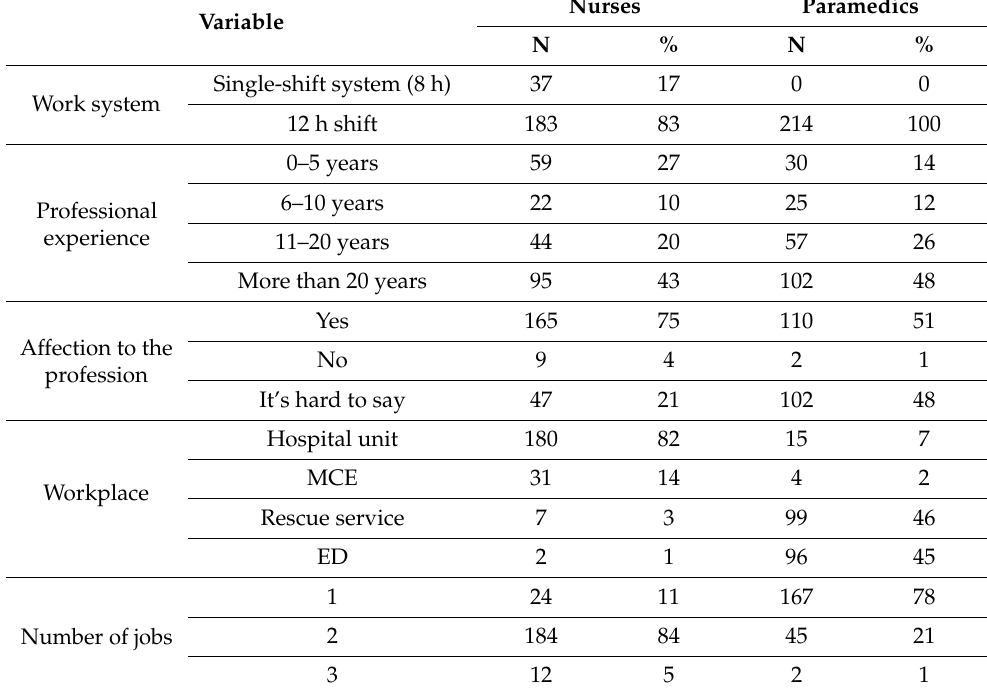
Table 2. Characteristics of the respondents’